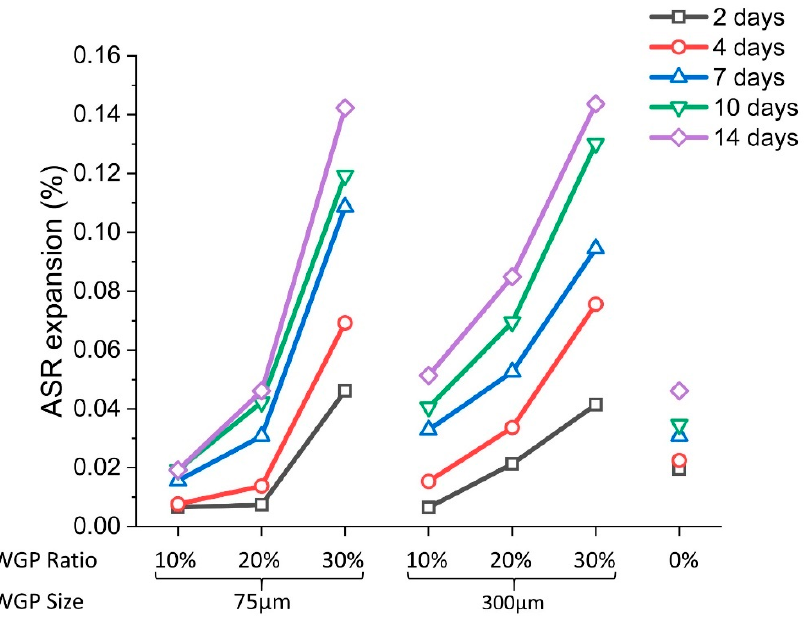
Figure 8. The ASR expansion of mortar containing WGP (10%, 20%, and 30%) with mechanical activation.